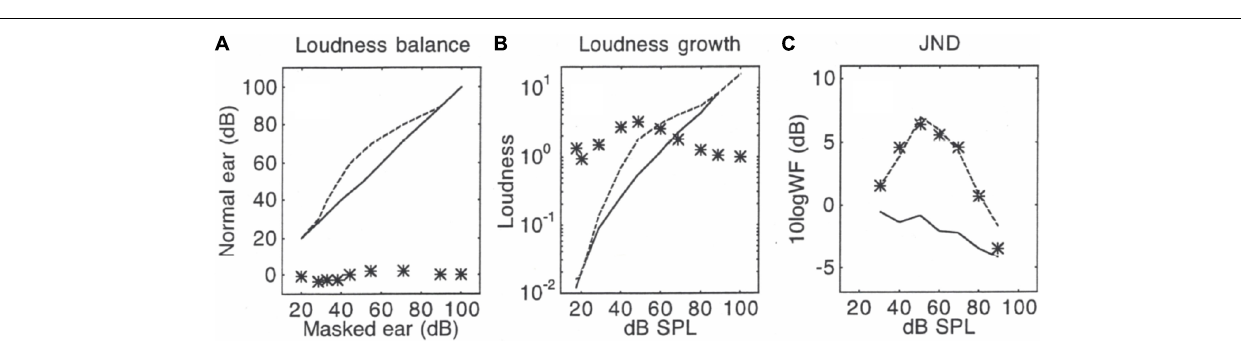
(solid line) based on Zwislocki’s model [Eq. (1), using k = 3.1; − 12 W/m 2 or 0 dB SPL], as well θ = 0.27; c = 2.5; I o = 10